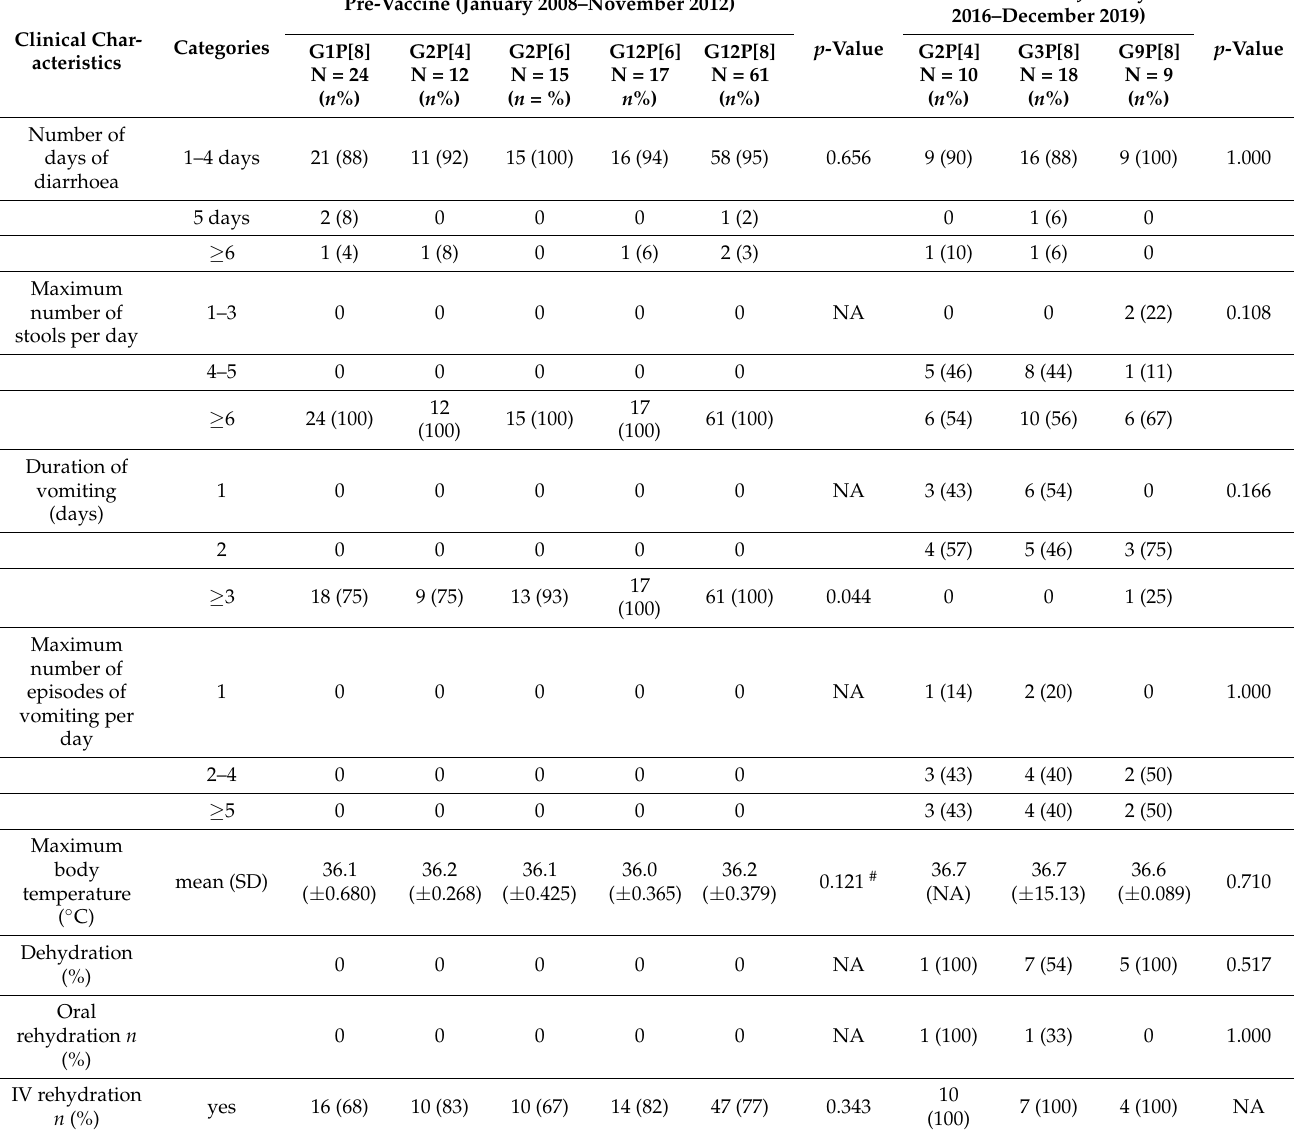
Table 3. Clinical characteristics of disease and rotavirus genotype combinations common in